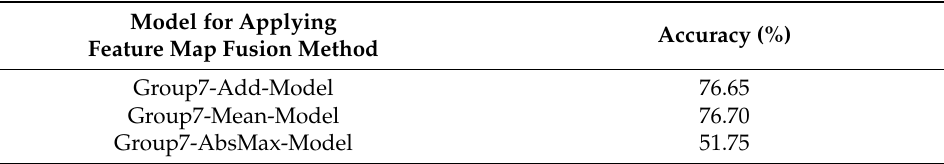
Table 3. Accuracy of feature map fusion methods on validation